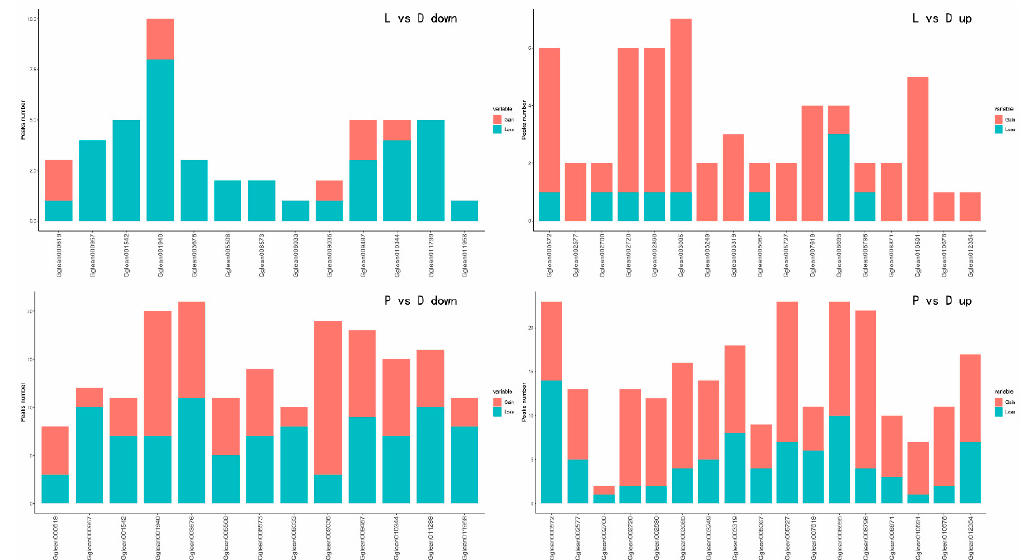
Figure 5. The changes in the chromatin open regions near the DEGs, for each group. The TSS site of the selected gene was expanded upstream and downstream to 100,000 bp, and the differential chromatin open regions of ATAC-seq were analyzed.